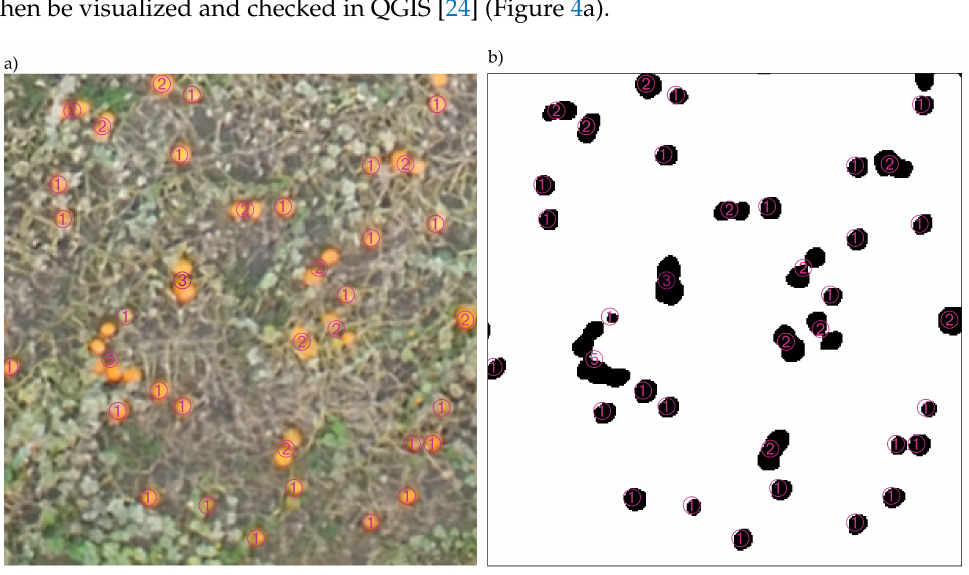
Figure 4. A section of orthomosaic with detected pumpkin blobs and the number of pumpkins they contain visualized ( a ) and the corresponding thresholded section ( b